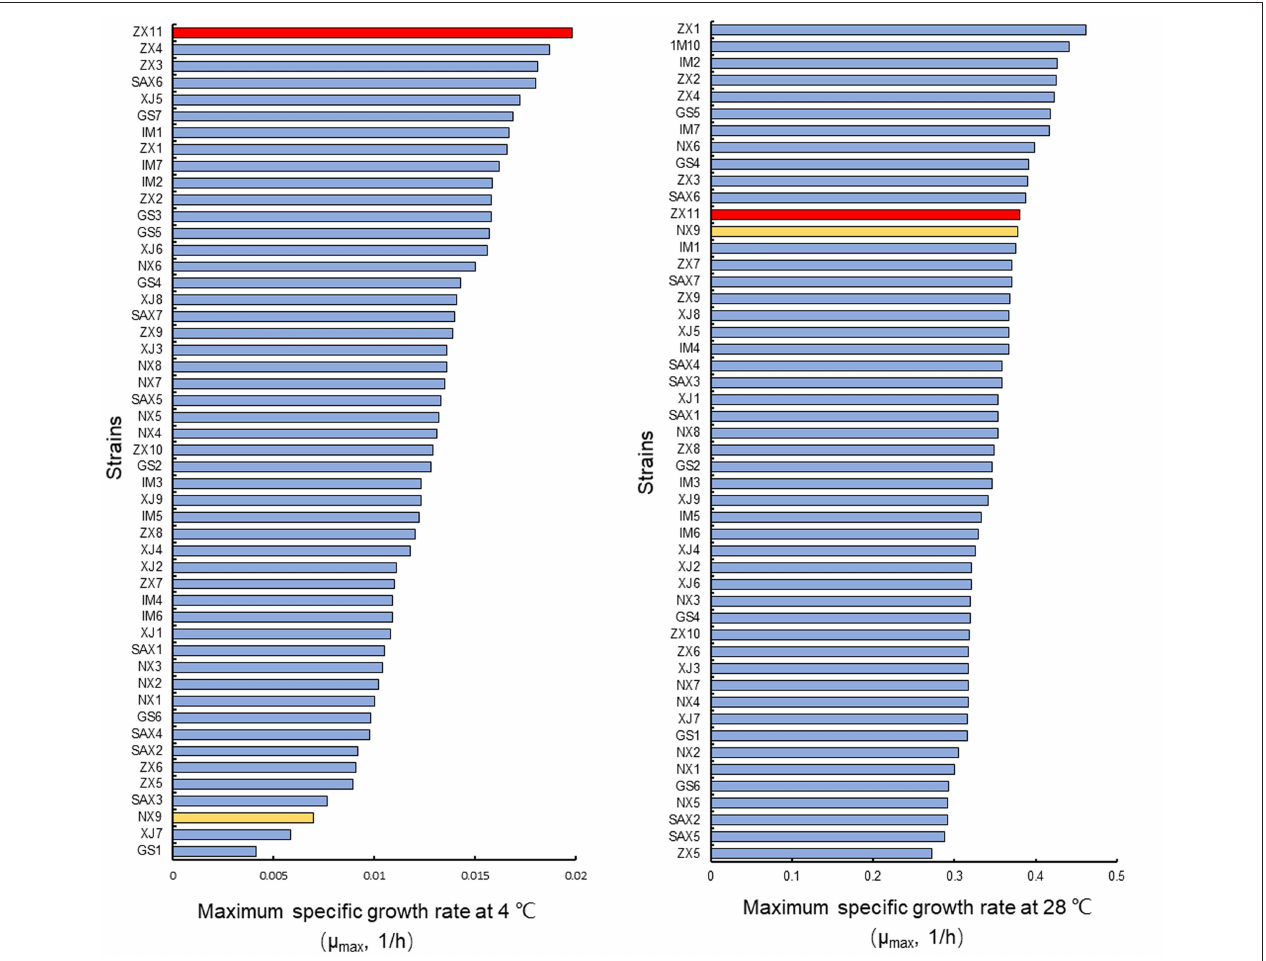
FIGURE 1 | Selection of strains with evident different growth performance at low-temperature. Strain ZX11 (red) and NX9 (yellow) were selected on the basis of the µ max values in YPD at 4 and 28 ◦ C. The strain ZX11 exhibited the best growth performance at 4 ◦ C of all strains tested. Strain NX9 was ranked among the strains with lower µ max values at 4 ◦ C. However, there was no significant difference in their growth performance at 28 ◦ C. Hence, ZX11 was selected as the superior strain, NX9 was selected as the inferior